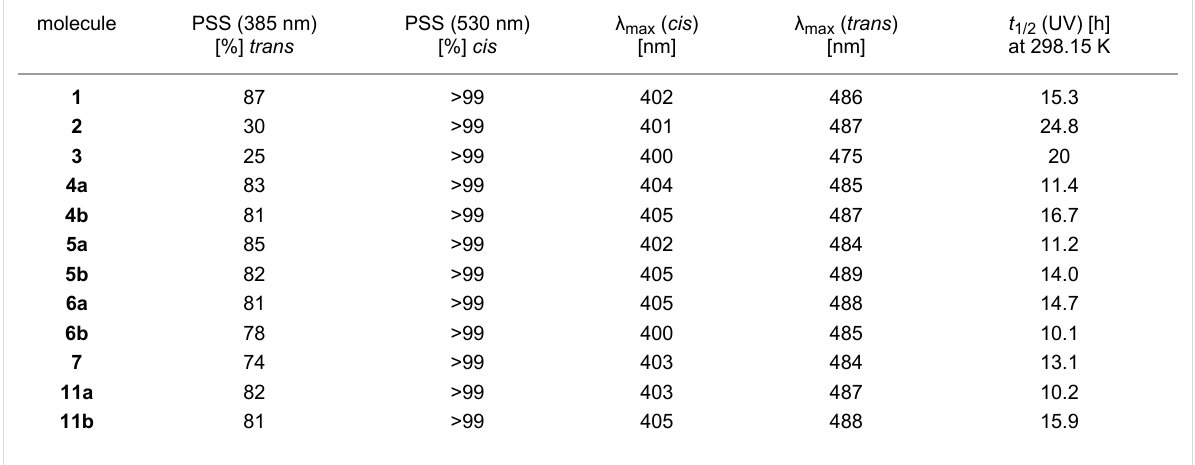
Table 1: Photostationary states (300 K), absorption maxima and half-lives (298.15 K), determined by 1 H NMR and UV–vis spectroscopy in aceto- nitrile. molecule